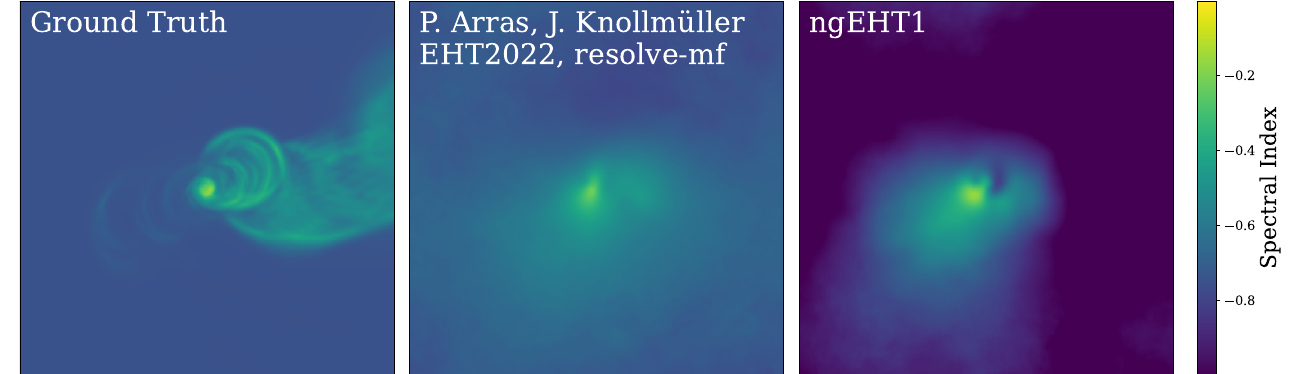
Figure 10. Spectral index maps of the Challenge 2 M87 ground truth model (first frame) and resolve reconstructions of the spectral index map with the EHT2022 and ngEHT1 arrays. The ground truth spectral index map was blurred with a Gaussian with a FWHM of 9.4 µ as.